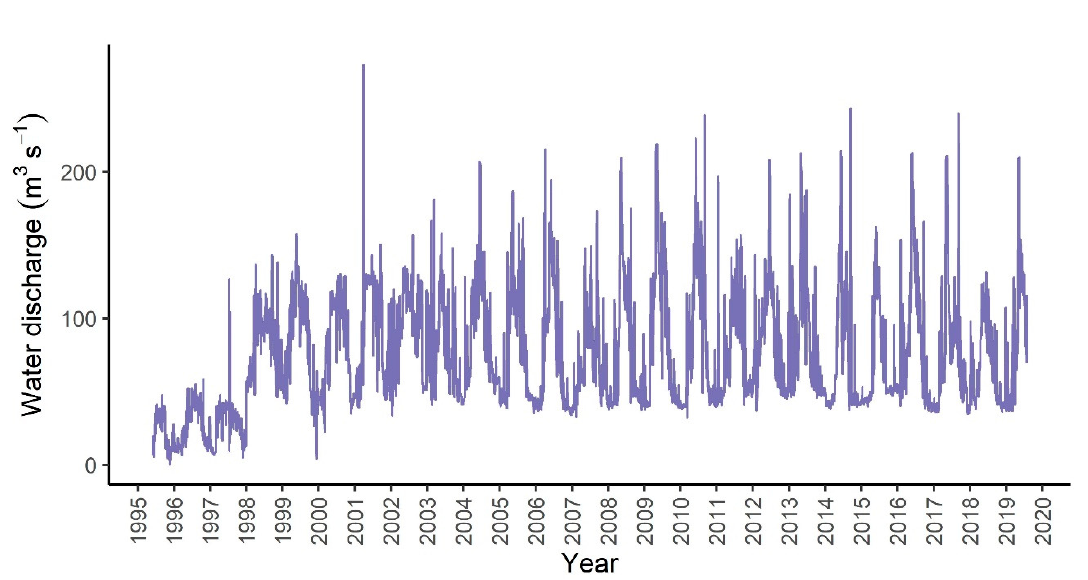
Figure A2. Picture of the deployed reed island.